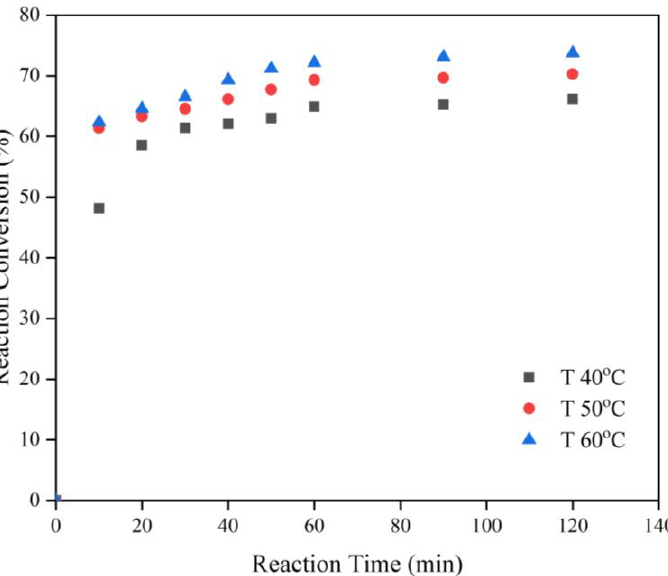
Figure 3. Effect of the Temperature and Reaction Time on the Reaction Conversion of FFA Esterifi- cation in CSO over SnCl 2 .2H 2 O Catalyst at the Molar Ratio of CSO: methanol of 1:30 and Catalyst Concentration of